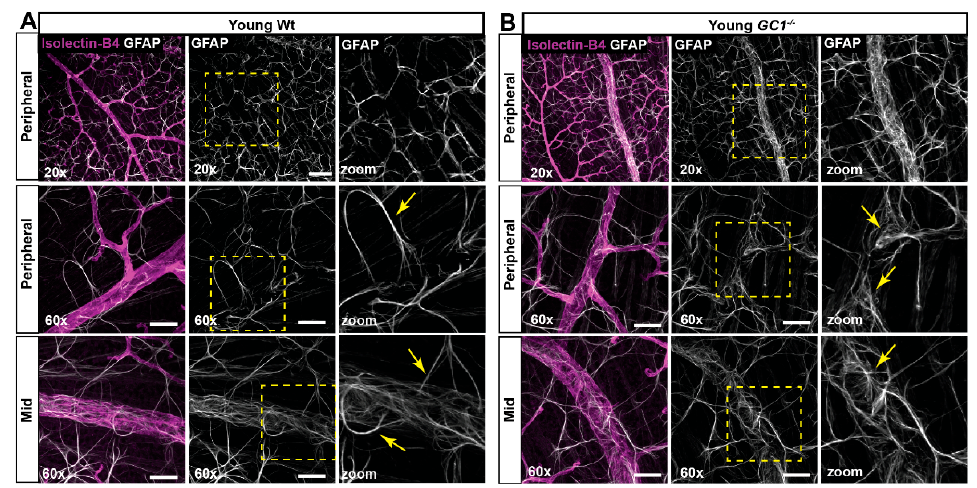
Figure 3. Astrocyte morphology in young Wt and GC1 − / − retina. ( A ) Representative confocal micrographs of astrocytes (GFAP; white) and blood vessels (isolectin B4; magenta) in peripheral and mid retina of young Wt mice. Astrocyte processes are long and striated (yellow arrows) with end feet wrapping the vessels. ( B ) Representative confocal micrographs of astrocytes (GFAP; white) and blood vessels (isolectin B4; magenta) in peripheral and mid retina of young GC1 − / − mice. Astrocyte processes are long, but end feet are increasingly frayed proximal to vessels (yellow arrows). Scale bars at 20× = 100 µm and at 60× = 40 µm.